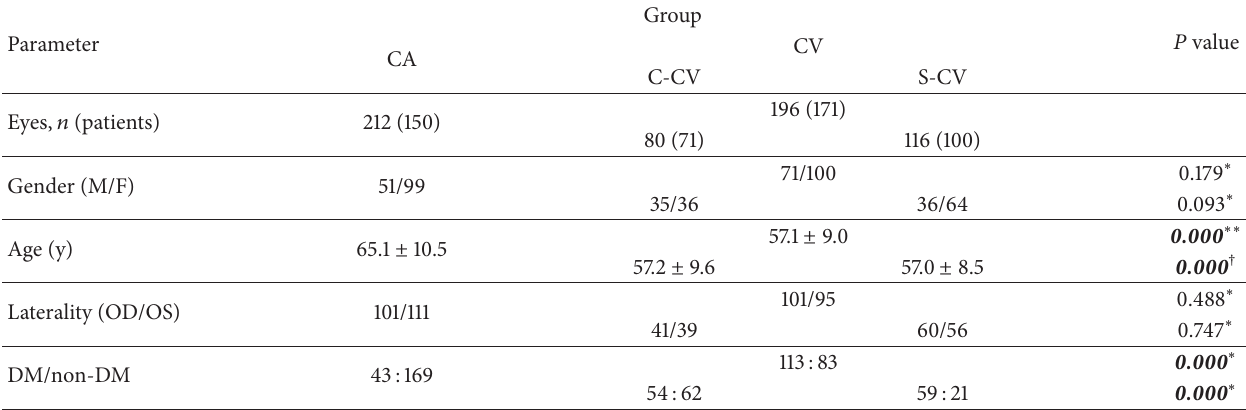
Table 1: Patient demographics.